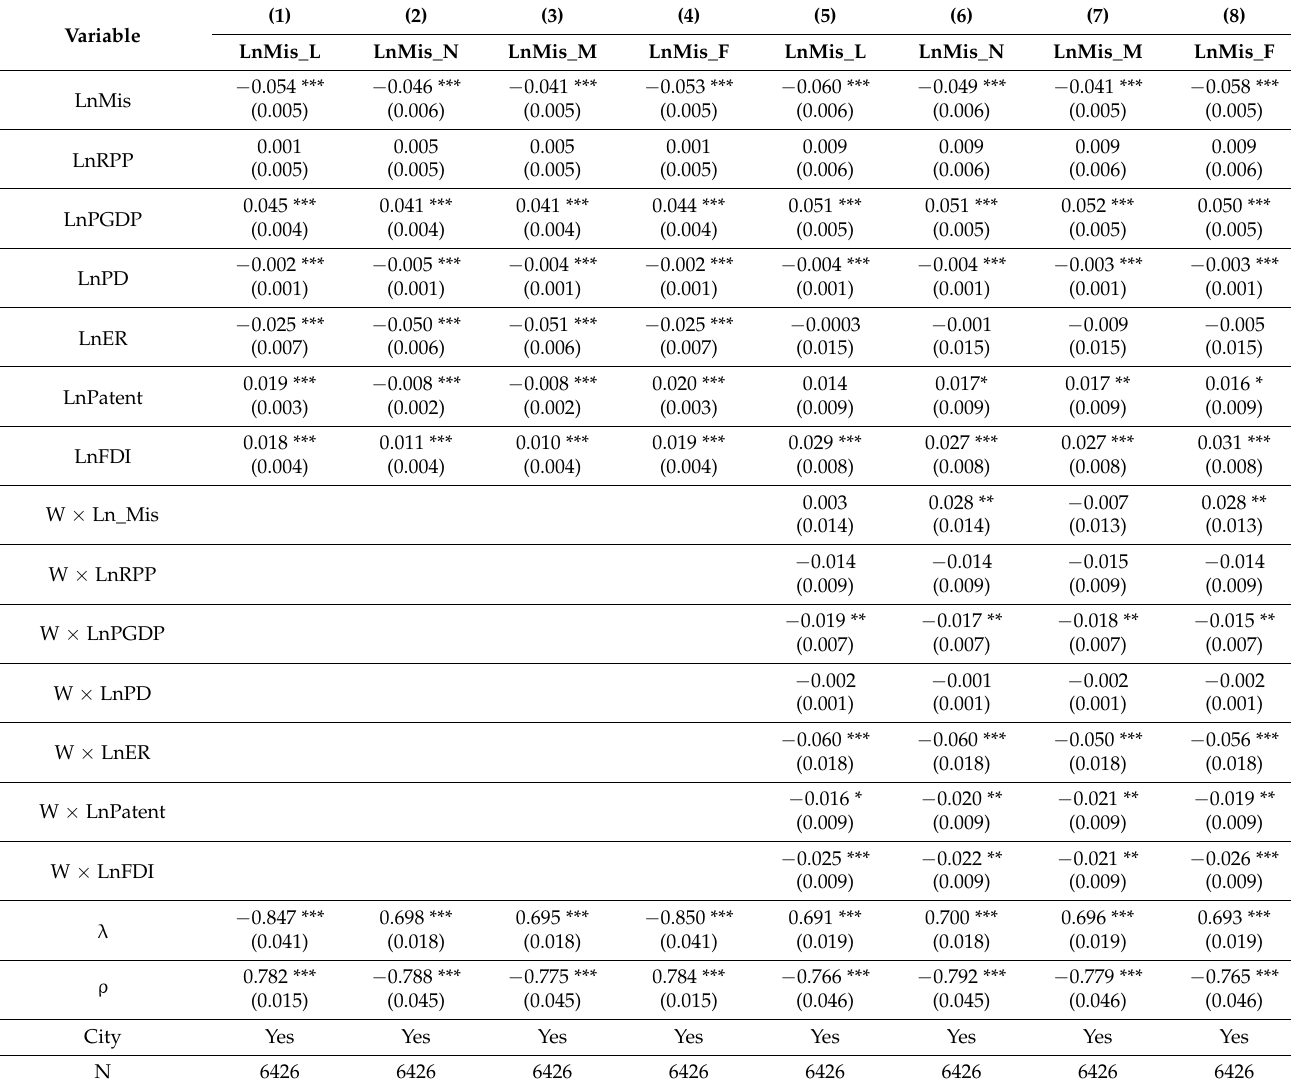
Table 8. Benchmark model